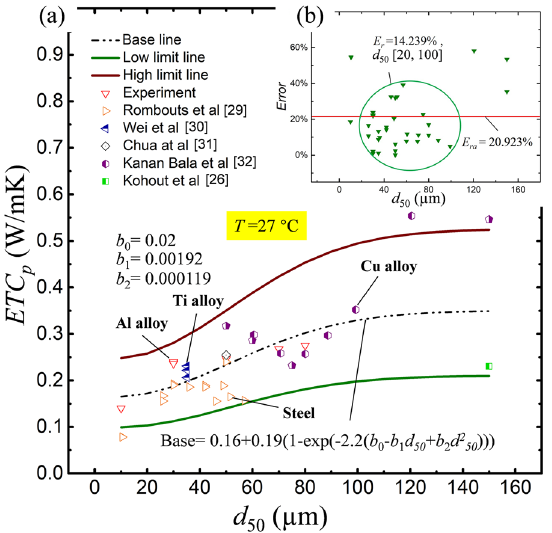
Figure 8 Comparison between theoretical data band and experimental data [26, 29–32]: a Calculation high limit ( δ limit ( δ 0.6) and base line; b Error analysis of theoretical data band = and experimental